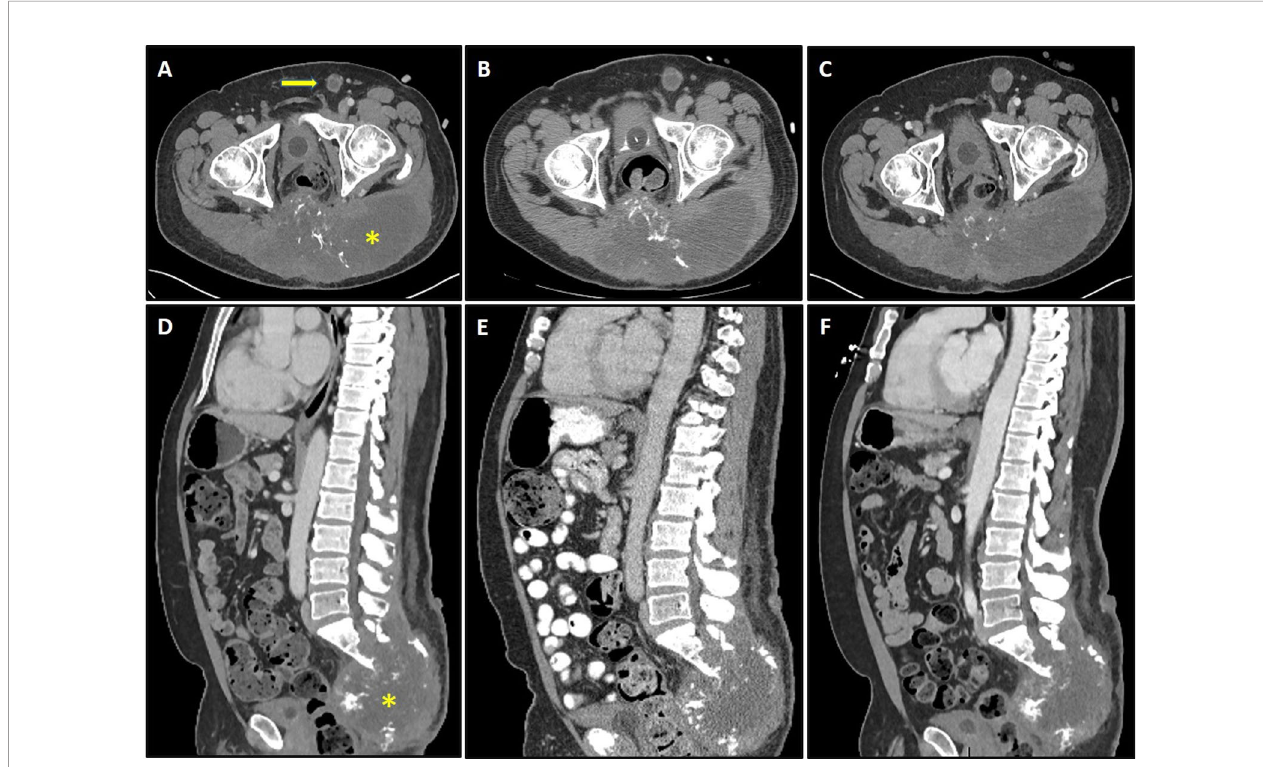
FIGURE 2 | Axial and sagittal sections of CT scans depicting sacral chordoma (asterisk) with left inguinal lymphadenopathy (arrow) prior to brachyury vaccine (A, D) , 4 weeks after the fi rst dose of vaccine (B, E) , and 16 weeks after the fi rst dose of vaccine (C, F) . Imaging demonstrates stable disease by response evaluation criteria in solid tumors (RECIST) criteria, with 1.54 and 3.38% changes in baseline at 4 weeks (B, E) and 16 weeks (C, F) ,